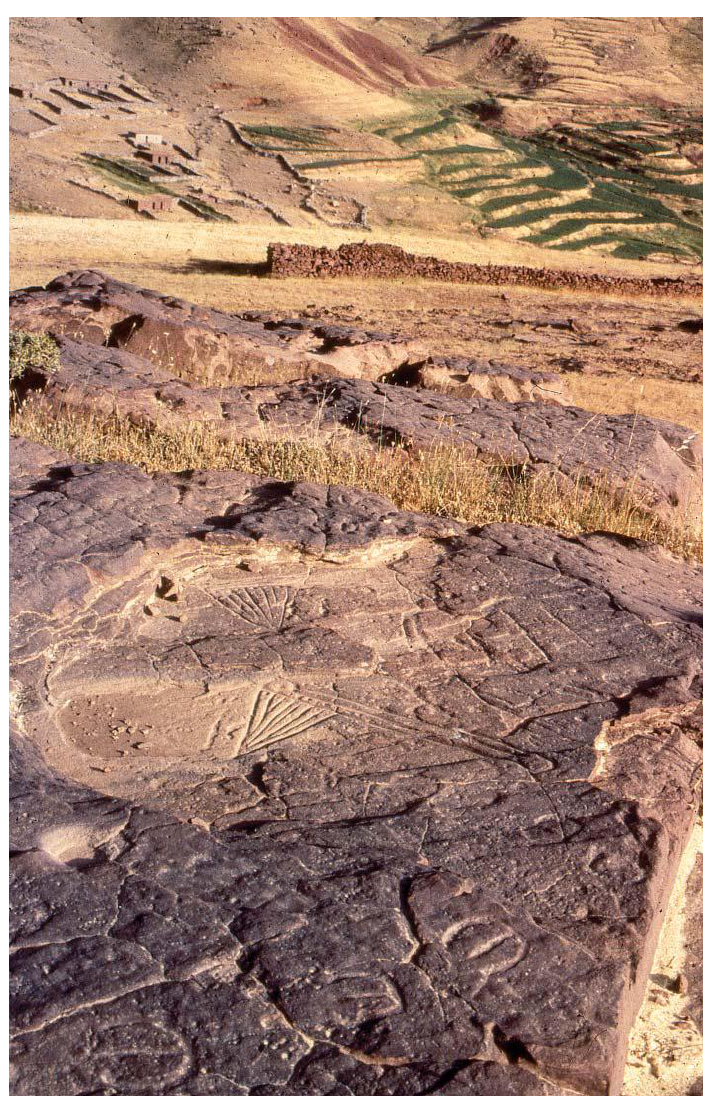
Figure 5. Halberds engraved on the Yagour Plateau, High